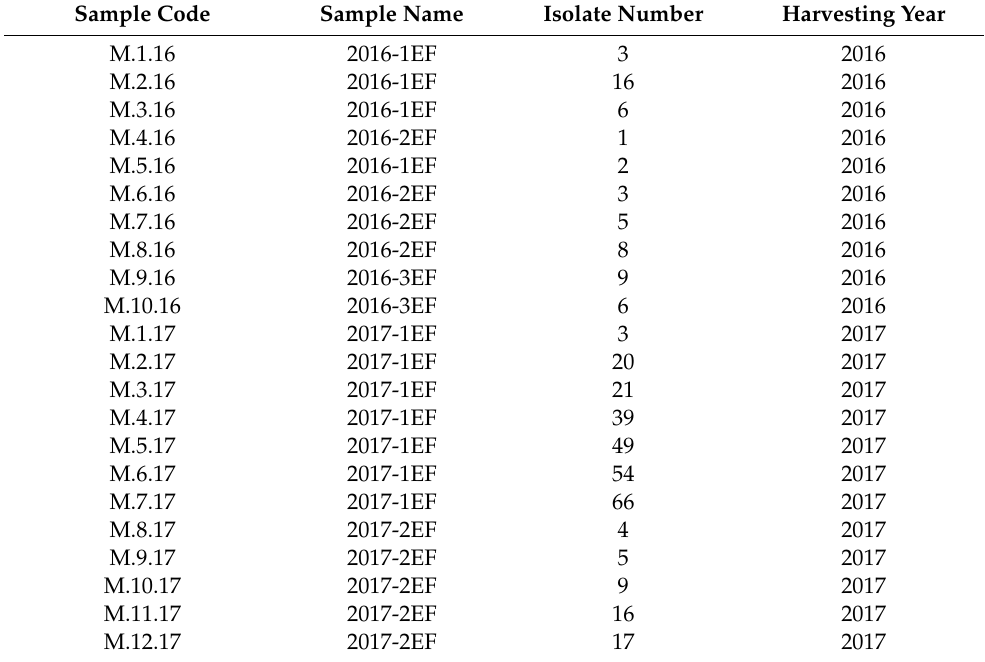
Table 2. Description of the 22 Lebanese indigenous S. cerevisiae strains used for the technological characterisation. EF = end of alcoholic